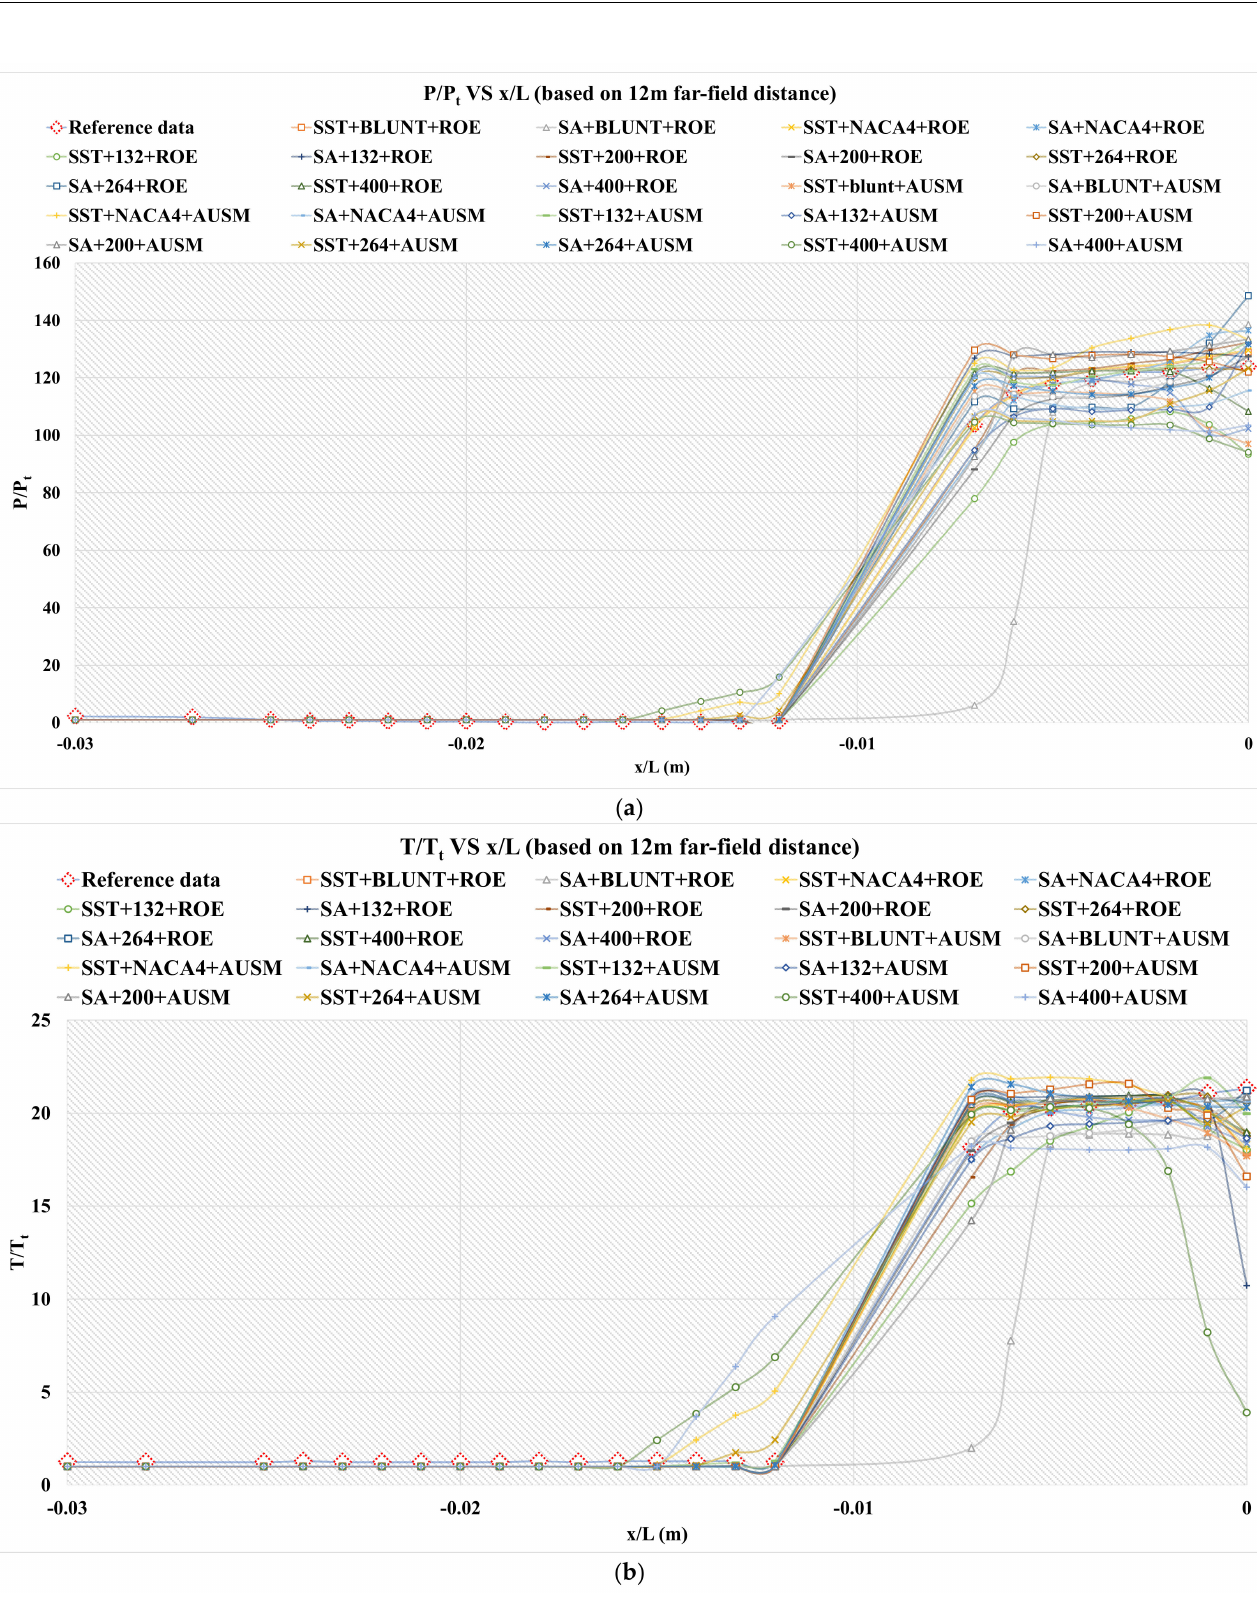
Figure 23. ( a ) Distributions of P/P t of 12 m far-field distance; ( b ) Distributions of T/T t of 12 m far-field